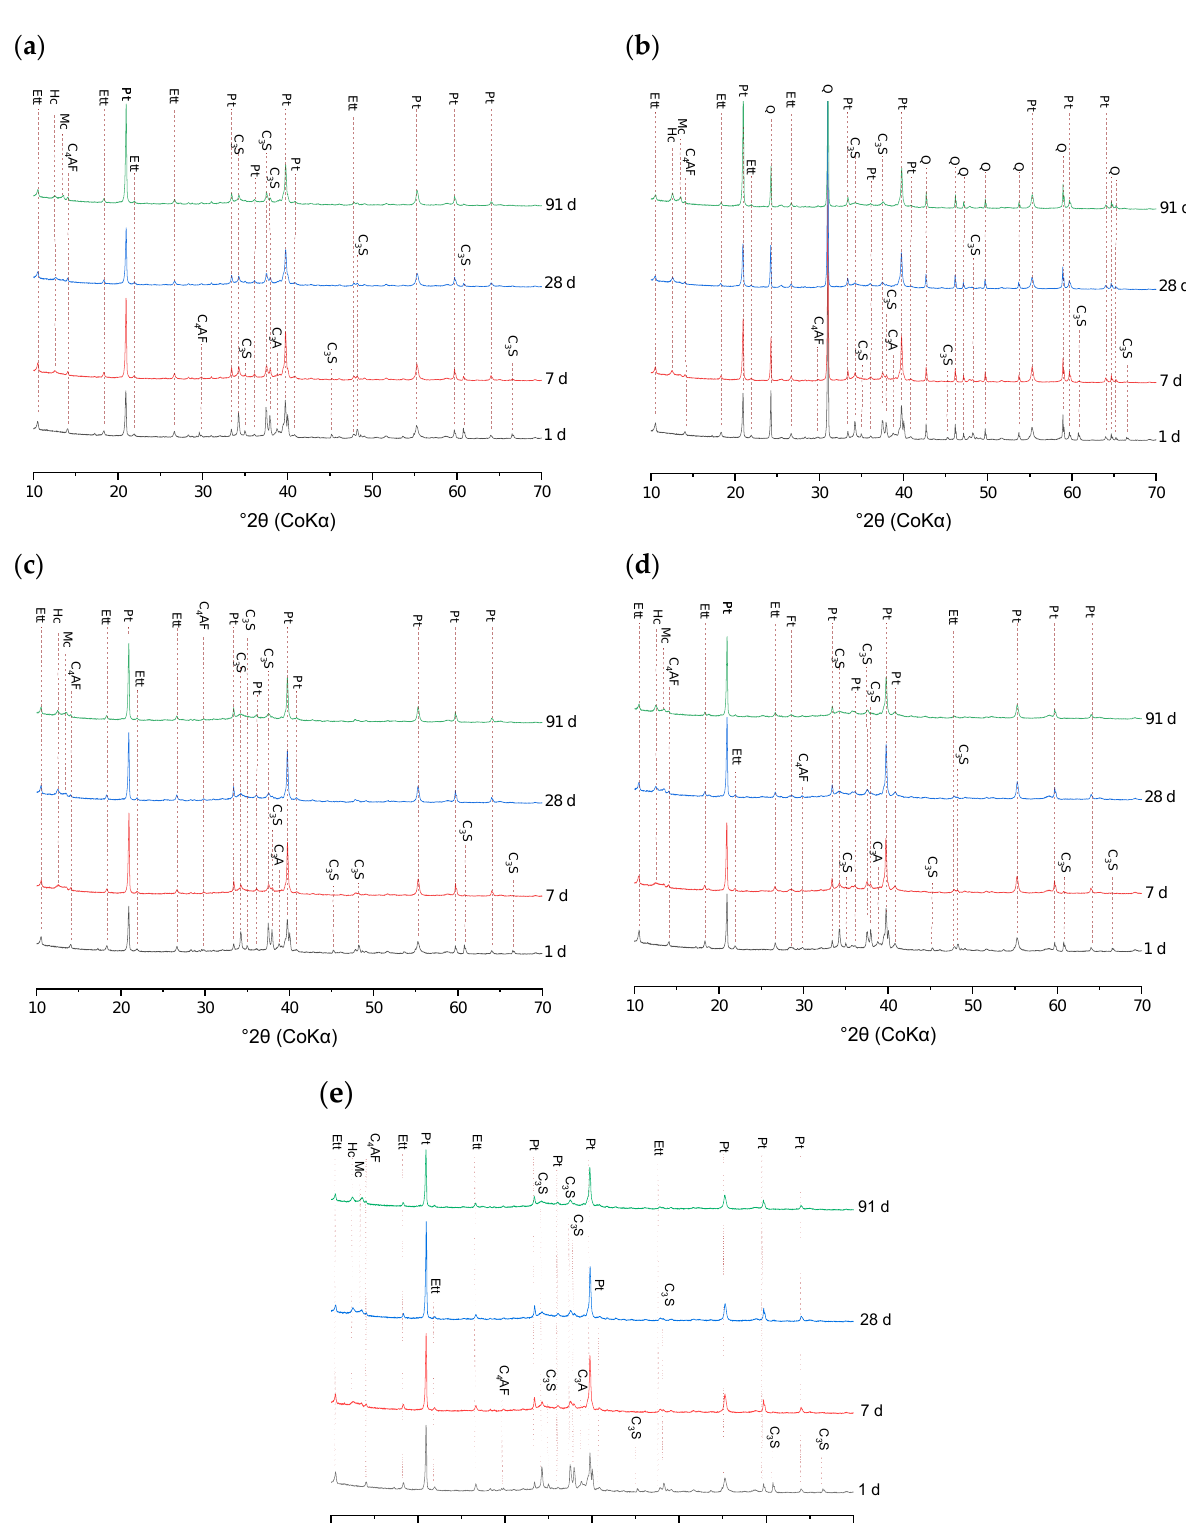
Figure 5. The evolution of X-ray patterns of different pastes over time: ( a ) P_PC, ( b ) P_QP, ( c ) P_TS1, ( d ) P_TS2 and ( e ) P_TS3. Ett: ettringite; Hc: hemicarboaluminate hydrate; Mc: monocarboaluminate hydrate; Pt: portlandite; Ft: fayalite.